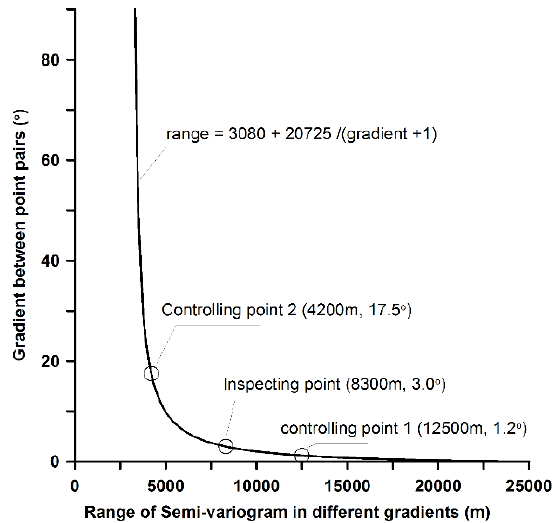
Figure 6. Fitted gradient/range function.